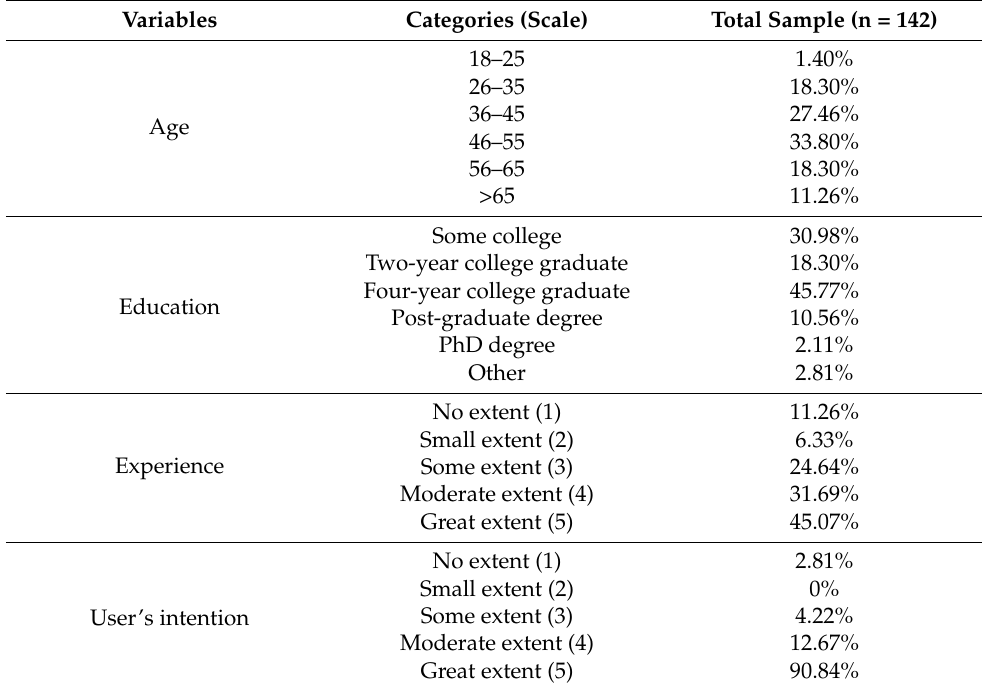
Table 3. Percentage distribution of the sample’s characteristics.